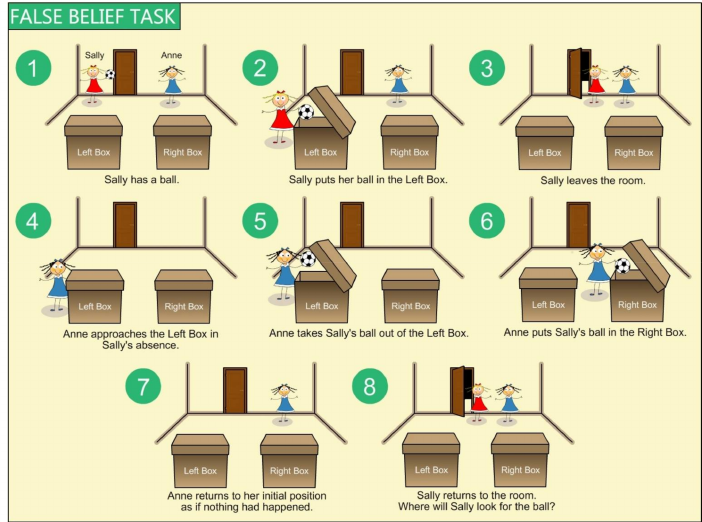
Figure 1. Sequence of the stimuli of the false belief